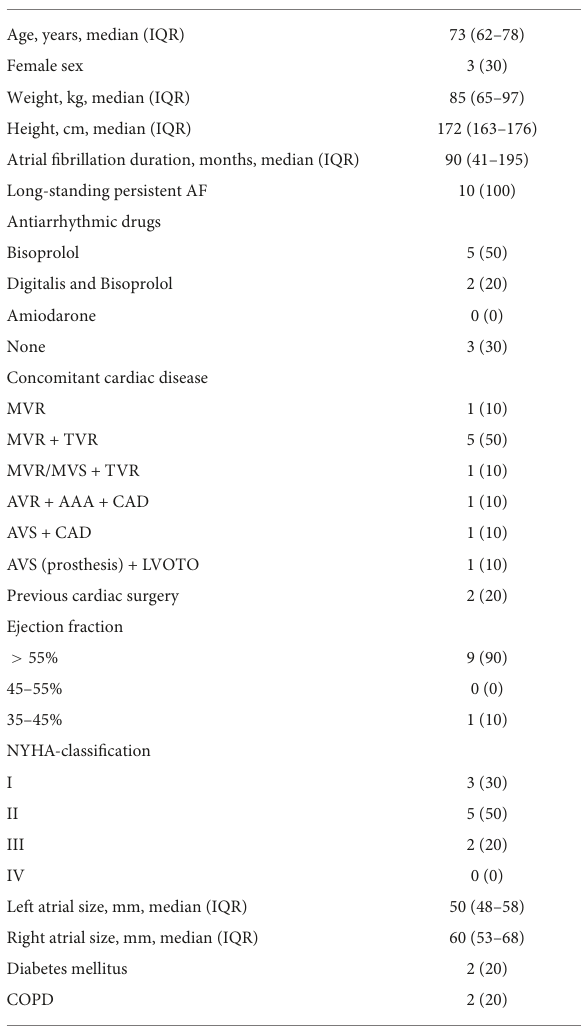
TABLE 1 Patient